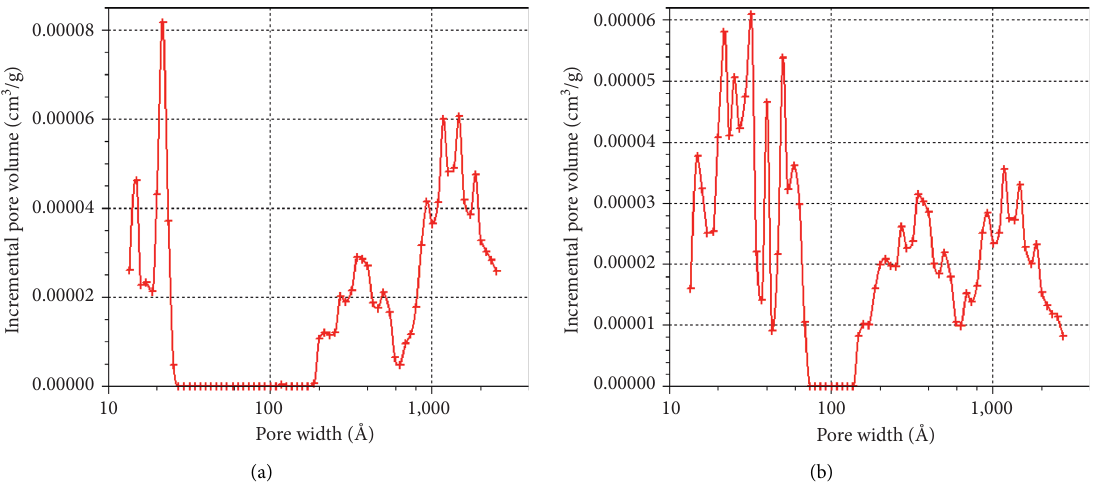
Figure 7: Relationship between the coal pore volume increments and the pore diameters of the No. 8 coal seam (˚A is 10 − 1 nm): (a) hard coal; (b) soft coal. Table 3: Influence effects of the coal pore distributions on the gas adsorption and diffusion. Peak points of the specific surface areas and Coal samples Micropores Small pores pore volumes increment